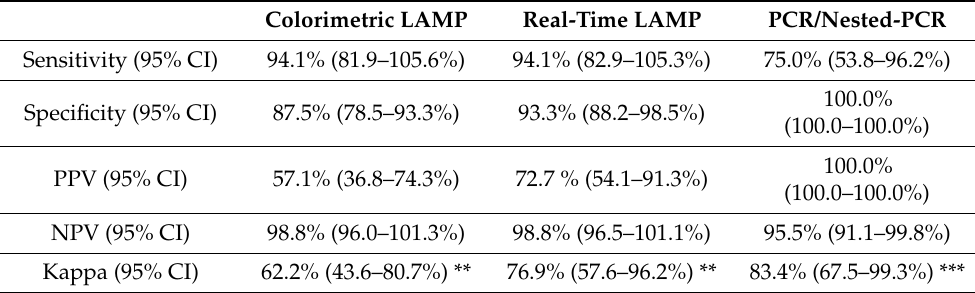
Table 2. Estimation of the accuracy of the molecular methods applied as diagnostic tests for Loa loa . Estimation of sensitivity, specificity, positive and negative predictive values and Kappa index by DNA amplification tests (colorimetric LAMP, real-time LAMP and PCR/nested-PCR) against microscopy as reference diagnostic method for current study for identifying Loa loa infection in the 100 patients’ dried blood samples analyzed. PPV, positive predictive value; NPV, negative predictive value; CI, confidence intervals; Kappa, Kappa